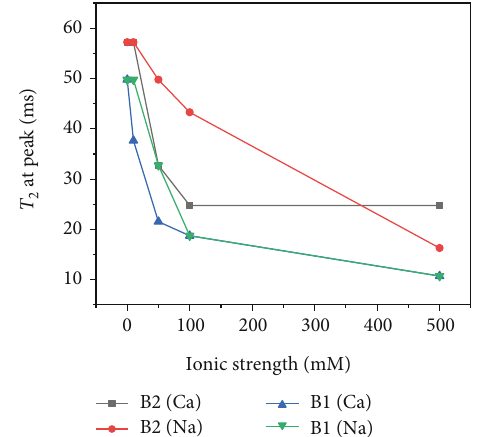
Figure 6: T 2 distribution curves and peak areas in